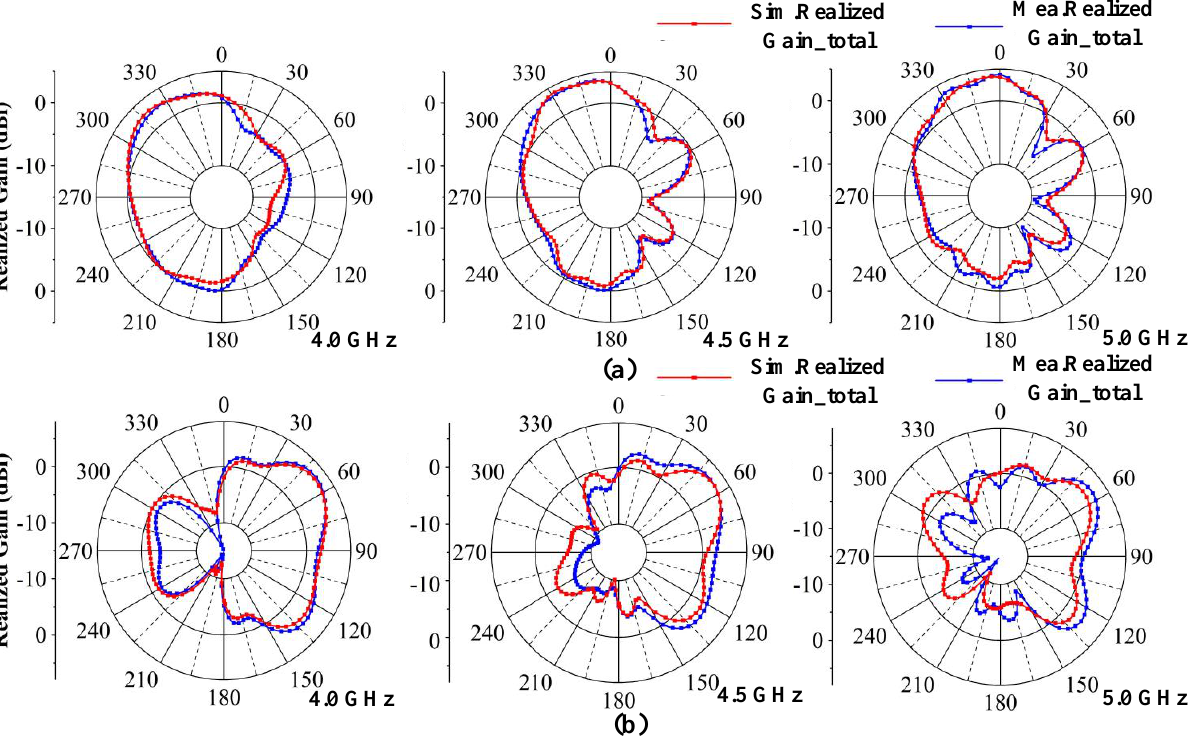
Figure 20. Simulated and measured radiation patterns of the proposed MIMO system in the 𝑦𝑜𝑧 plane. ( a ) Ant 1. ( b ) Ant 2.